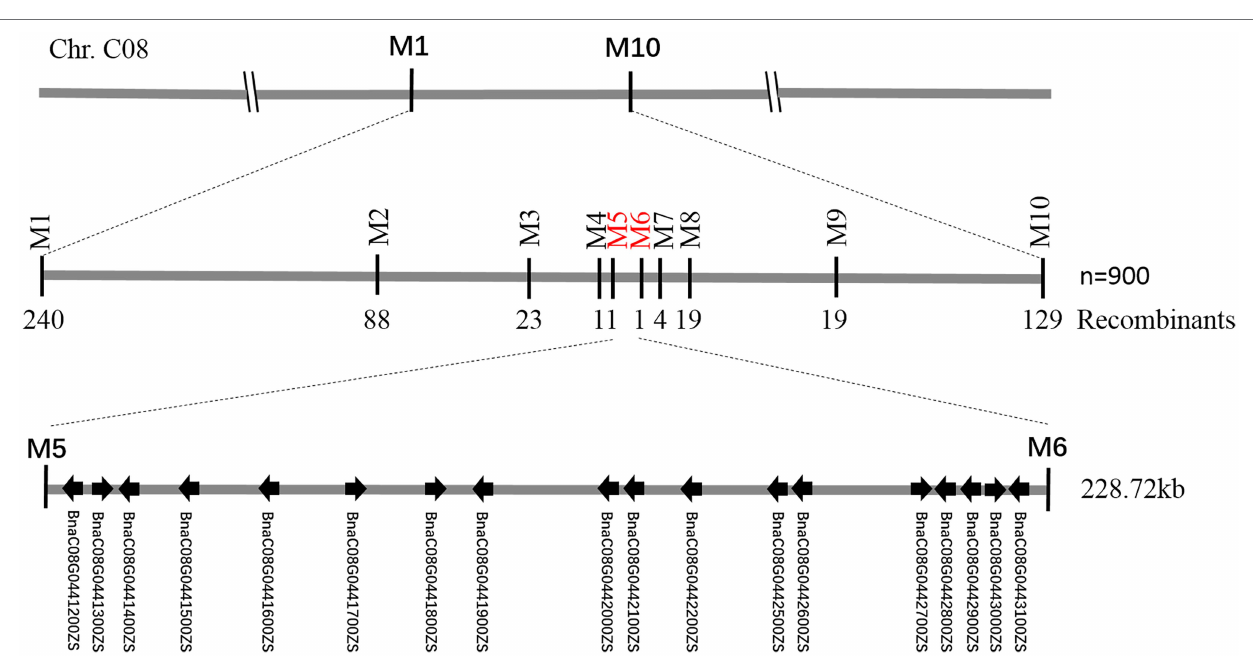
FIGURE 5 | Fine-mapping of BnC08.cds . Using 900 recessive individuals of F 2 population derived from the cross between df74 and ZS11, the BnC08.cds was mapped to a 228.72 kb interval on Chromosome C08, restricted by PARMS SNP markers M5 and